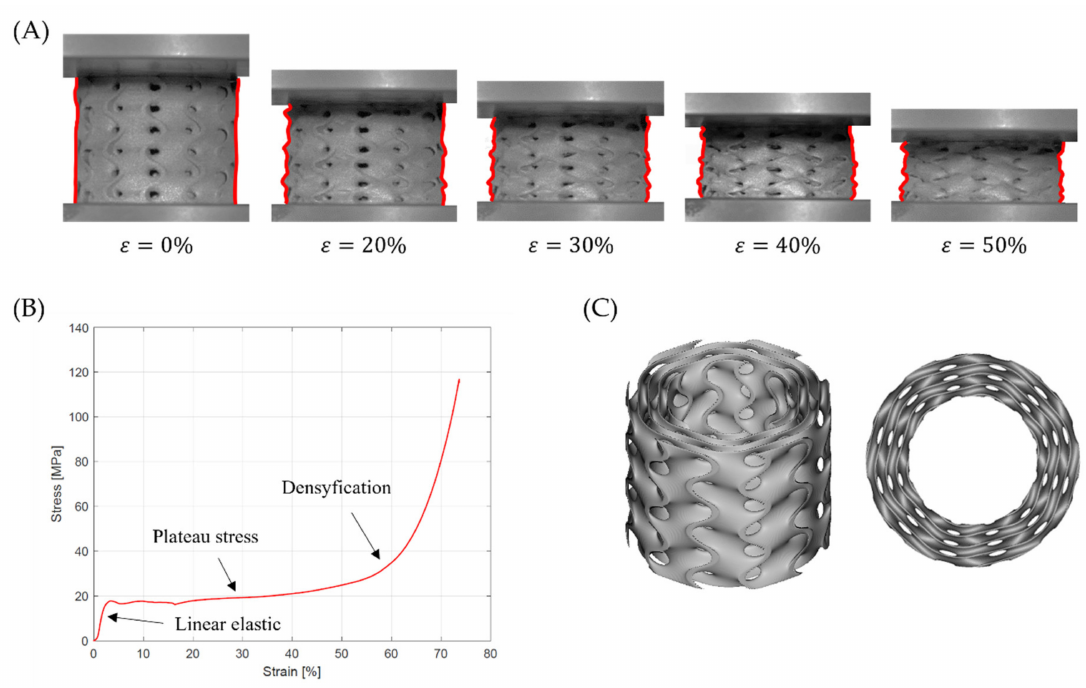
Figure 16. “Layer-by-layer” deformation mode with incomplete densification of collapsing layers on the example of Gyroid_6_2_20_0.73 samples: ( A ) deformation stages in the presence of 0%, 20%, 30%, 40%, 50% strain recorded by ARAMIS measurement system; ( B ) compressive stress–strain curve; ( C ) CAD